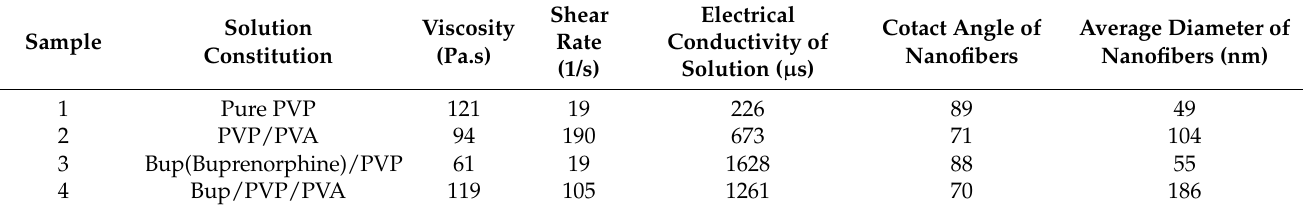
Table 2. The properties of electrospinning solutions.